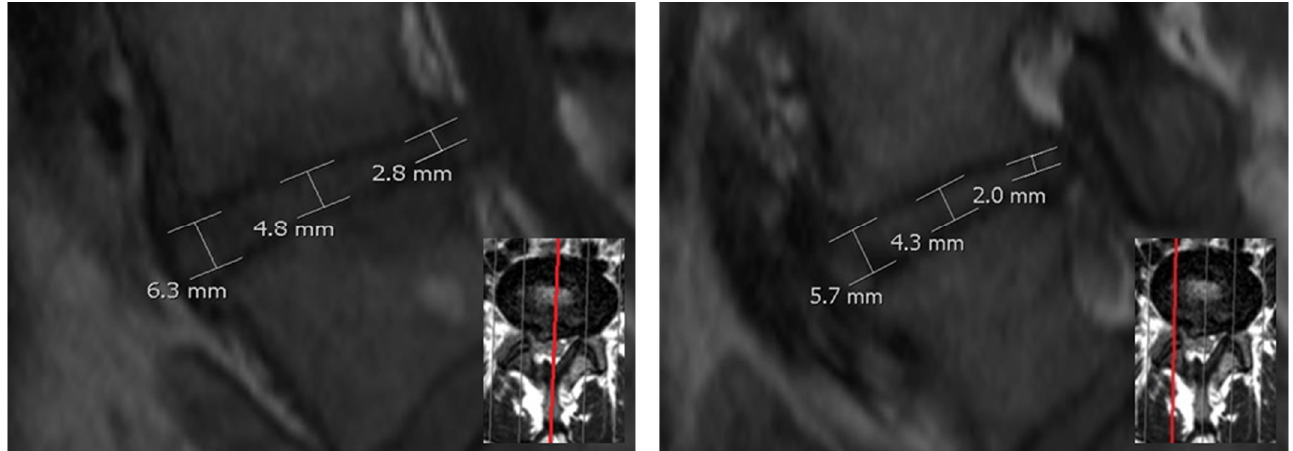
Figure 1. Left image: Measurement of disc height for the methods H1 (disc height in the center) and H2 (mean of anterior and posterior disc height) midsagittal (red line). Right image: Example of the H3 method using additional parasagittal (red line) layers.